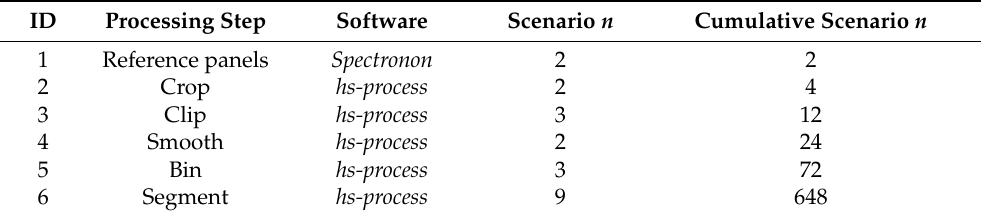
Table 2. List of image processing steps, software used, number of experimental workflow scenarios evaluated at each step, and the cumulative workflow scenarios with the addition of each processing